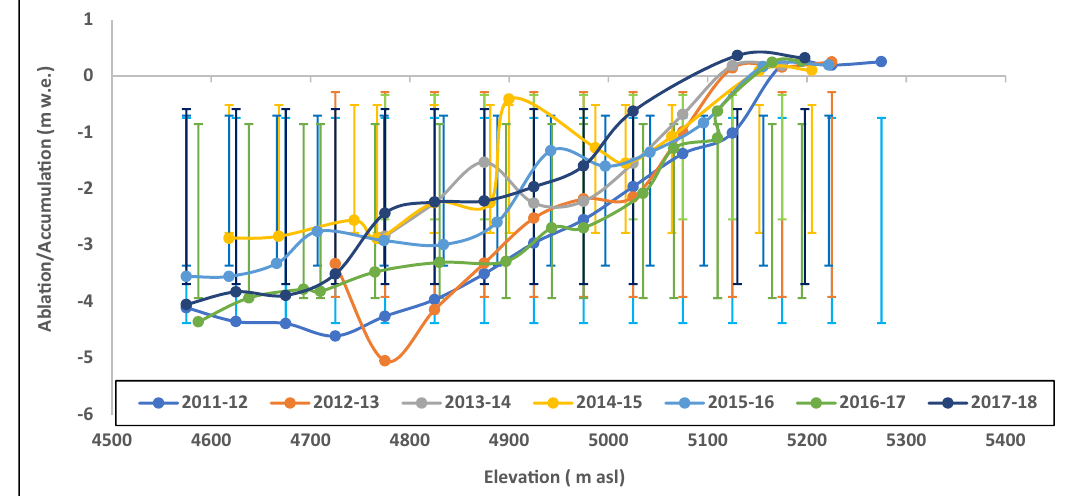
Figure 2. Specific accumulation/ablation with elevation during the ablation years 2011–12 to 2017–18. The vertical error bars indicate the standard deviation (± 1σ) of the accumulation/ablation.